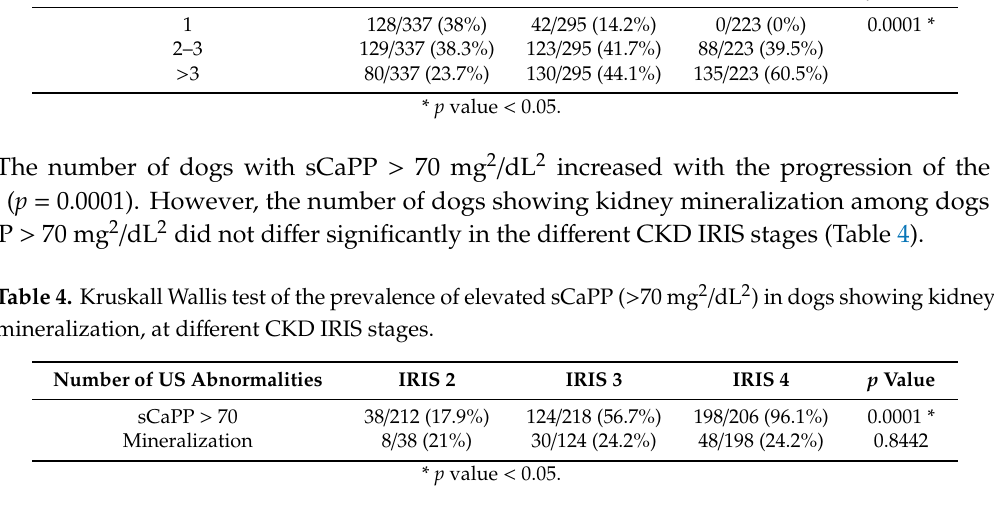
Table 3. Prevalence of one or more ultrasound abnormalities in di ff erent CKD IRIS stages. Number of US Abnormalities